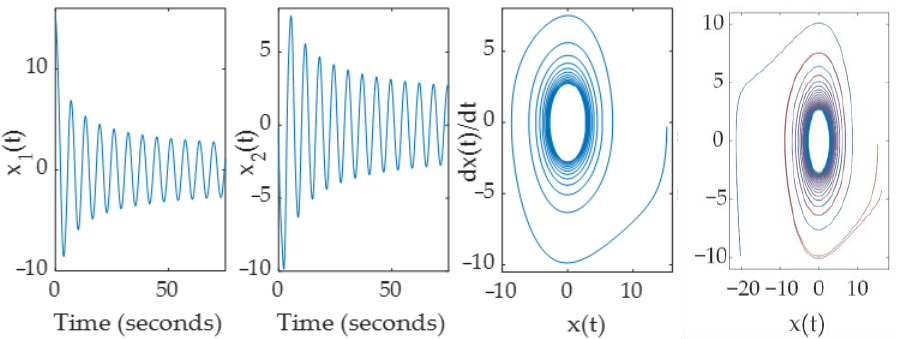
Figure 2. Left: The response and phase plot of a non-forced, dampened van der Pol oscillator for one set of initial conditions. Right: The phase plot for multiple initial conditions; note the divergence of trajectories characteristic of a chaotic system.